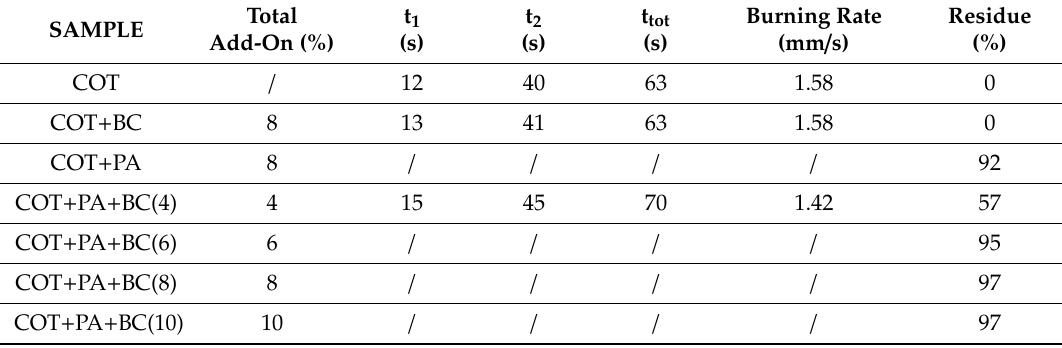
Table 3. Results of horizontal flame spread tests performed on cotton and on the treated fabrics.